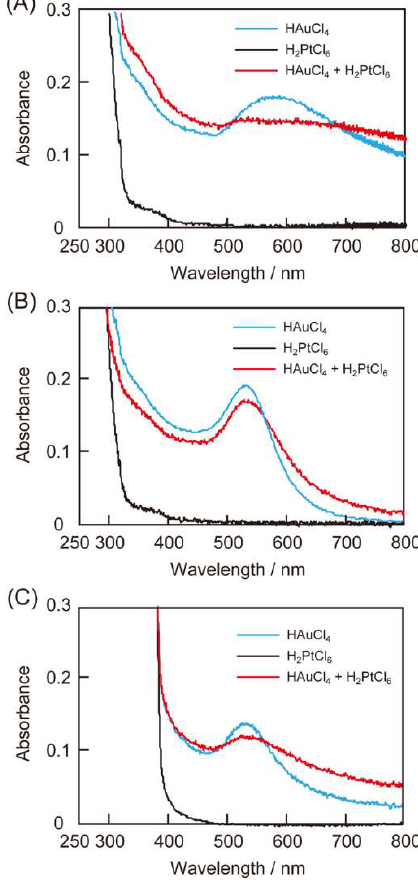
Figure 2. UV-Vis spectra of reaction mixtures of peptides ( A ) RU006, ( B ) (NaI 2 )-RU006 and ( C ) (Ant 6 )-RU006) and metal ion(s) (blue lines: HAuCl 4 only, black lines: H 2 PtCl 6 only and red lines: HAuCl 4 + H 2 PtCl 6 ). (Peptide) = 2.0 × 10 − 4 M and (HAuCl 4 ) = (H 2 PtCl 6 ) = 5.0 × 10 − 5 M in water. Each reaction was conducted at 40 °C for 24 h in the dark.